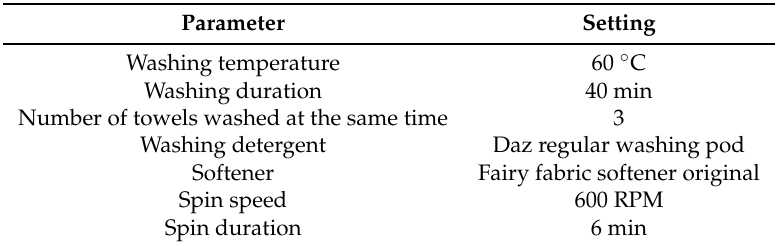
Table 4. Details of the washing procedure of the towel-integrated